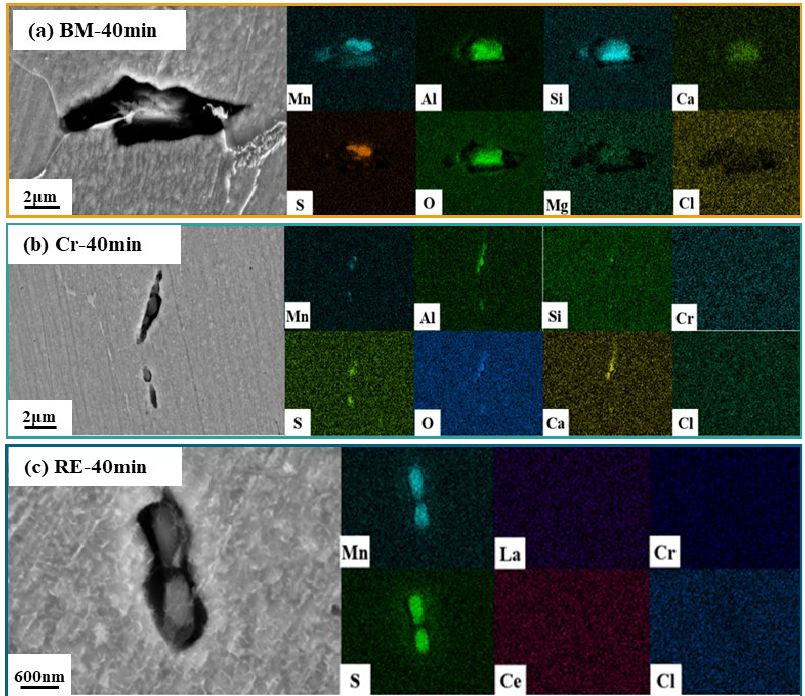
Figure 4. Immersion test results of ( a ) BM, ( b ) Cr, and ( c ) RE steel rebars after 40 min.